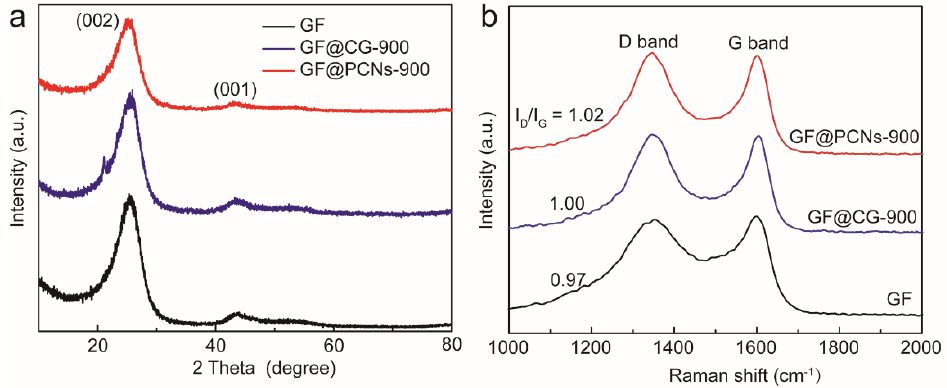
Figure 5. ( a ) XRD and ( b ) Raman spectrums of GF, GF@CG-900 and GF@PCNs-900.